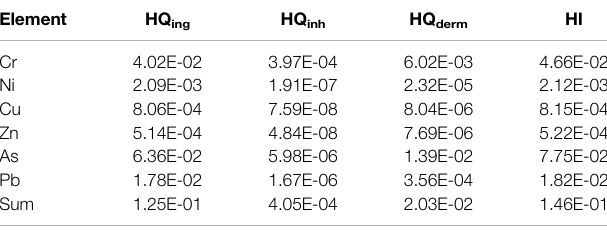
TABLE 6 | Non-carcinogenic health risks under different exposure routes. Element HQ ing